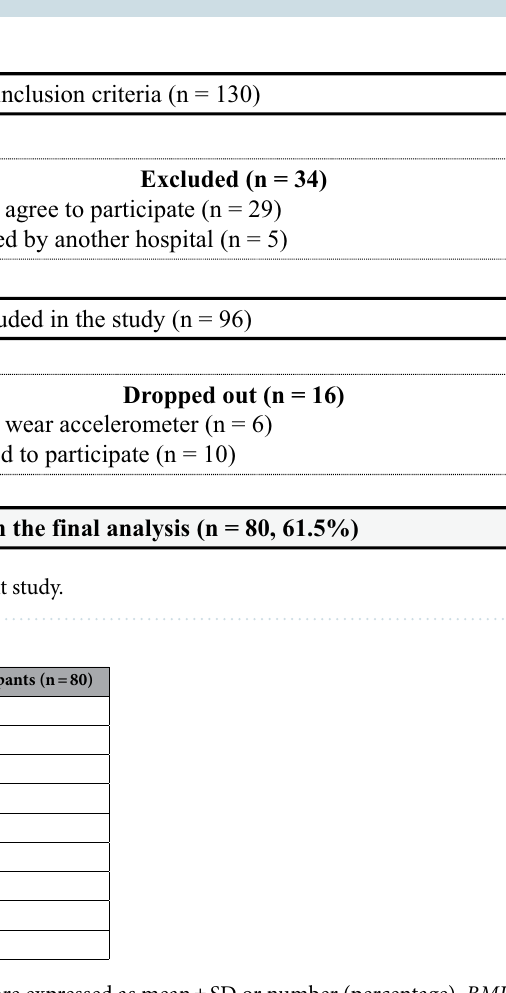
Table 1. Clinical characteristics. Data are expressed as mean ± SD or number (percentage). BMI body mass index, NIHSS National Institutes of Health Stroke Scale.